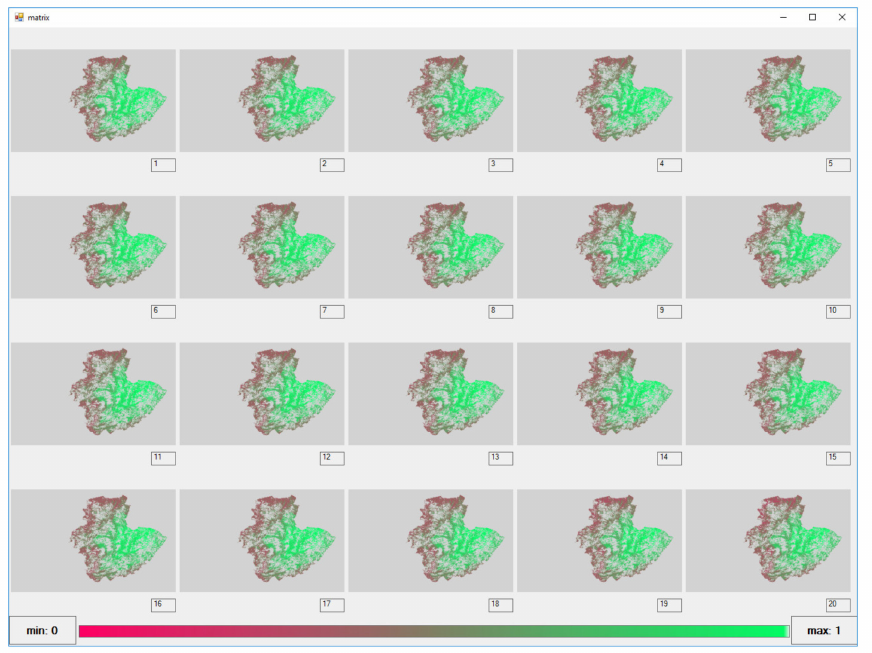
Figure A3. Value distribution (on a 0 to 1 scale) for Biomass III (B3) over a period of 20 years (t1 to t20. in the Nordeste region, Portugal. Light green cells indicate higher suitability and light red cells lower suitability of forest units for industry.